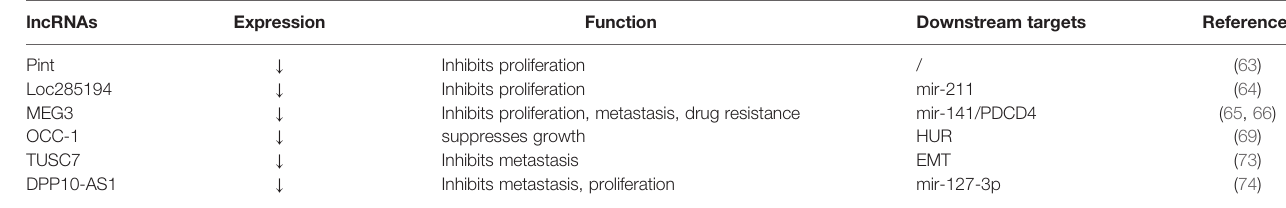
TABLE 3 | Inhibitory lncRNAs in